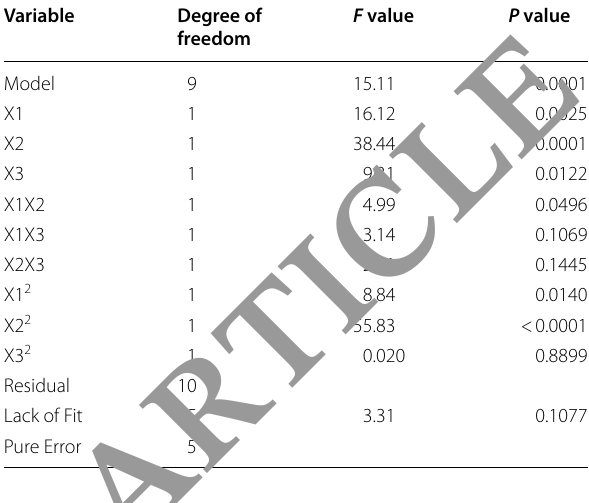
Table 5 Variables and their levels employed in CCD Components(g/L)